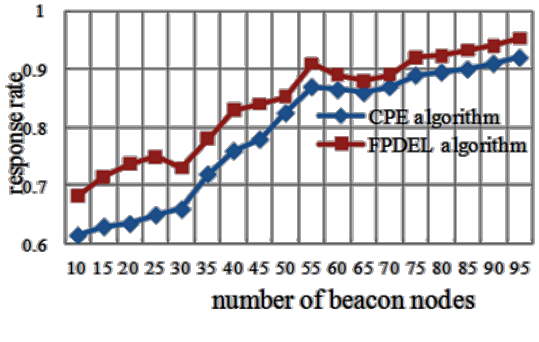
Figure 13. Number of Beacon Nodes vs. Mean